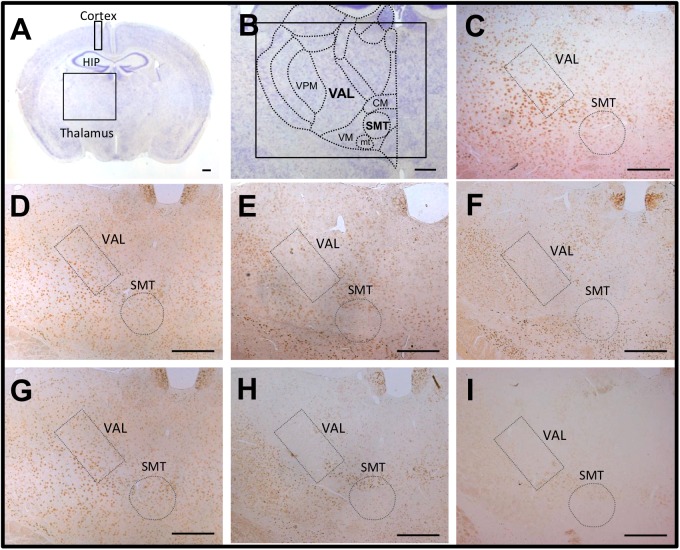
Temporal profile of NeuN-immunostaining in the hippocampus of WT, homozygous Slc19a3 KO, and Slc19a3 KI mice.NeuN-immunoreactive neurons in the submedial nucleus of the thalamus (SMT) and ventral anterior-lateral complex of the thalamus (VAL). A. Low magnification of a Nissl-stained brain slice at the level of the hippocampus (HIP). B. High-magnification overview of the specific regions of the thalamic area of a WT mouse. C. Closer view of a region contained in the inset of panel B. D–E. Brain slices of a homozygous KO mouse fed with thiamine 1.71 mg/100 g food for 12 days (D), thiamine 0.6 mg/100 g food for 5 days (E) and for 12 days (F). G–I. Brain slices of a homozygous KI mouse fed with thiamine 1.71 mg/100 g food for 14 days (G), thiamine 0.6 mg/100 g food for 14 days (H) and thiamine 0.27 mg/100 g food for 14 days (I). Scale bar, 200 μm. VPM: ventral posteromedial nucleus of the thalamus, CM: central medial nucleus of the thalamus, VM: ventral medial nucleus of the thalamus, mtt: mammillothalamic tract.